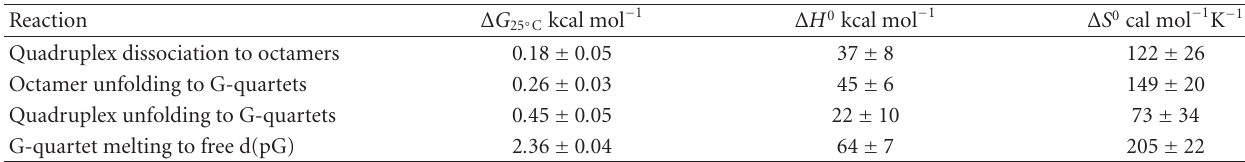
Table 3: Thermodynamic parameters for the di ff erent chemical equilibria described by (5). Data are reported on a per mole of guanosine